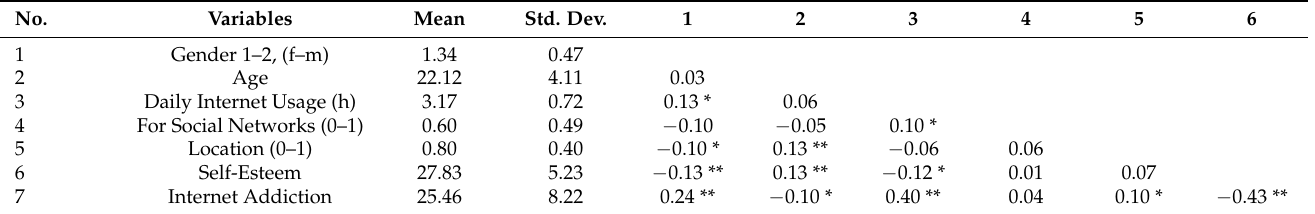
Table 2. Means, standard deviation and